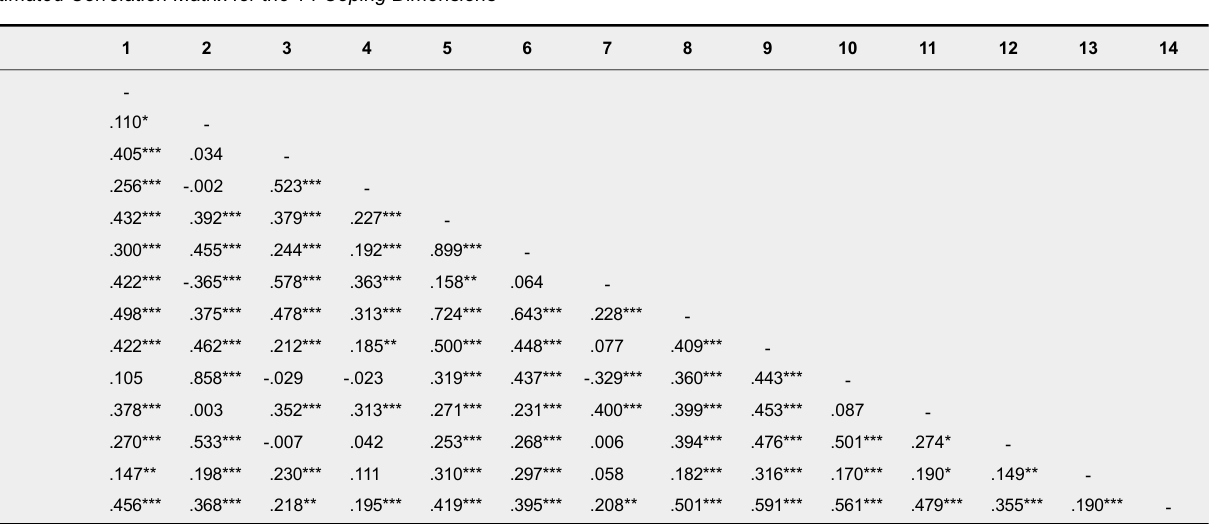
Estimated Correlation Matrix for the 14 Coping